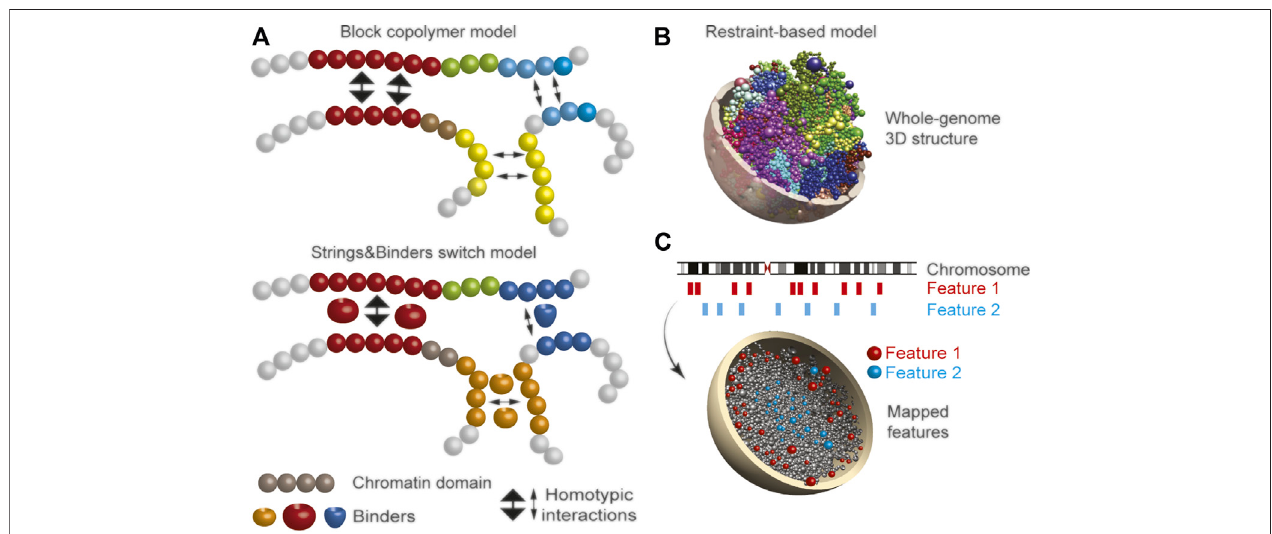
FIGURE 2 | Main polymer physics modeling approaches for chromatin (A) Top, block copolymer modeling of chromatin folding relying on homotypic interactions between domains (blocks) ofsimilarepigenomic signatures (colors). Variations the strength of these interactions are introduced to model heterochromatic (thick arrows) or euchromatic (thin arrows) homotypic interactions. Bottom, a variant of block copolymer modeling: here, “ binders ” (e.g., transcription factors) mediate homotypic chromatininteractions (B,C) Restraint-basedmodeling (B) 3Dmodelexampleofawholehumangenomestructure;eachcolorde fi nesachromosomeasachainof beads, with one bead representing a topological domain identi fi ed from Hi-C data (here, in adipose stem cells). The model integrates Hi-C and lamin B1 ChIP-seq (LAD) restraints for chromatin and is generated with our Chrom3D platform (Paulsen et al., 2017) (C) 3D chromatin modeling enables spatial visualization of genomic features not detectable in 1D data; here, feature 1 is more peripherally located than feature